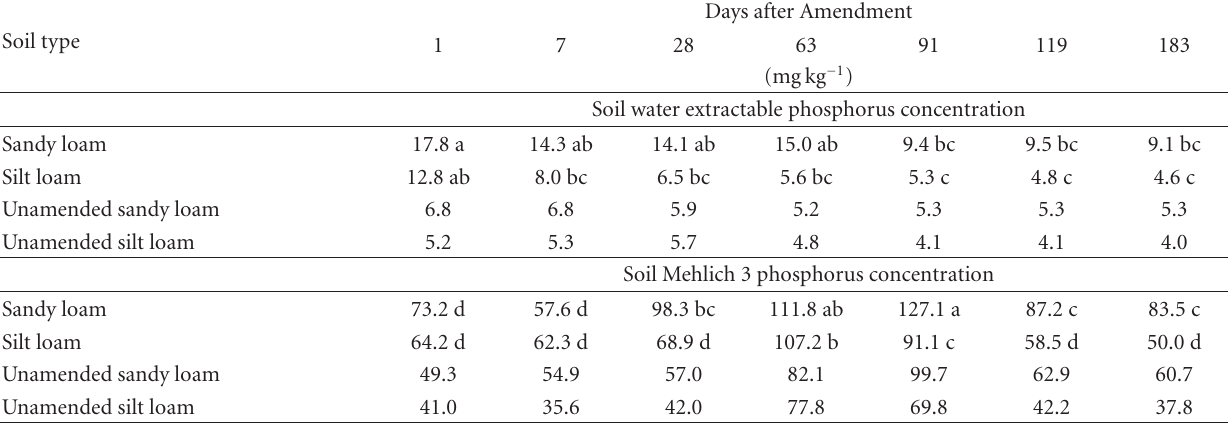
Table 3: E ff ect of soil type and time on soil water-extractable phosphorus and Mehlich 3 phosphorus concentrations averaged across phos- phorus saturation level and gypsum rate † .